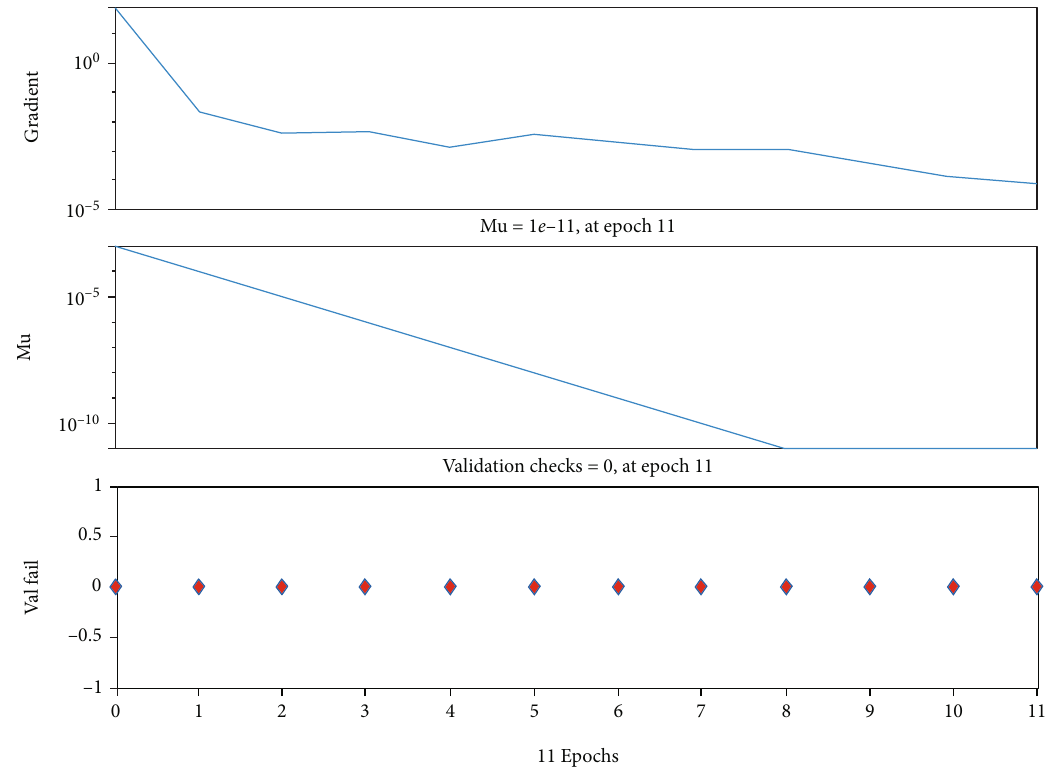
Figure 27: Training data of a DNN-based current